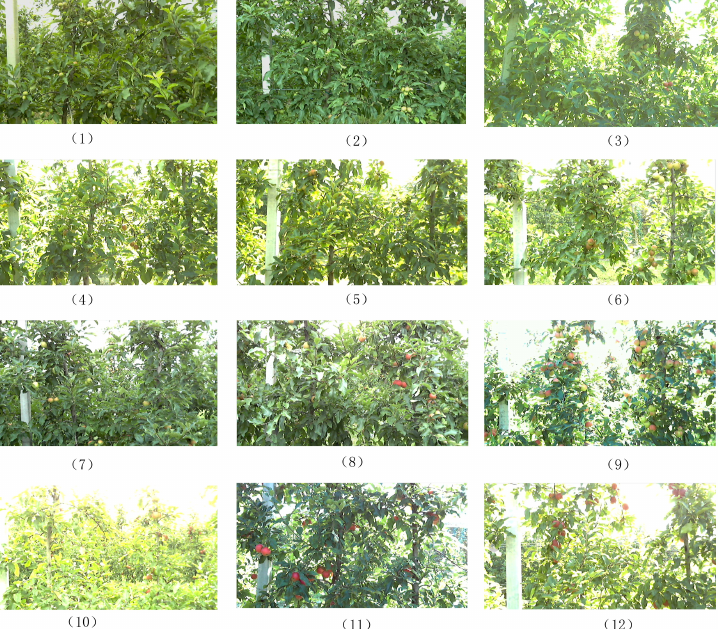
Figure 2. Collected samples from a variety of growth periods. From item (1) to (12), it represents the process of changing the appearance of the Fuji fruit from immature to totally